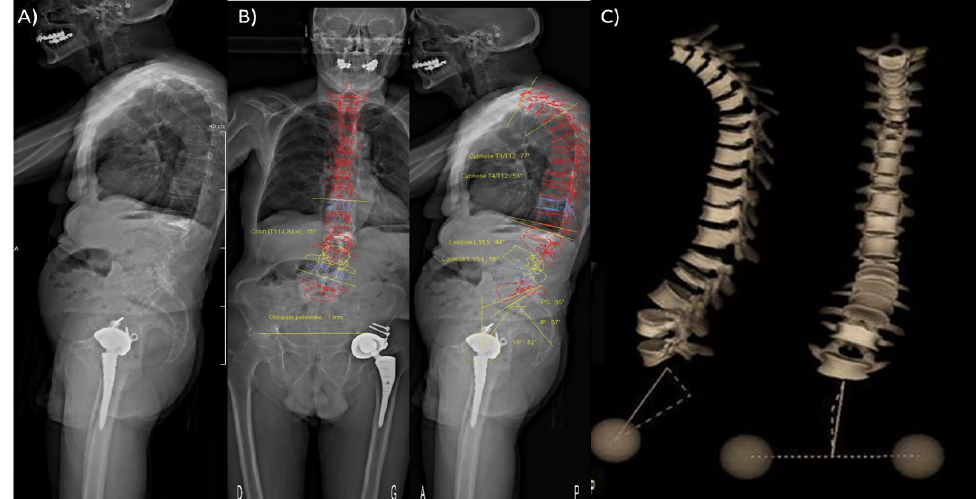
Figure 4. ( A ) Low dose full-body scan in standing position obtained using the EOS system ® . ( B ) Semi-automatic measurement of spinal statics and pelvic angles on front and profile images. ( C ) 3D- reconstruction of the whole vertebral column in standing position.